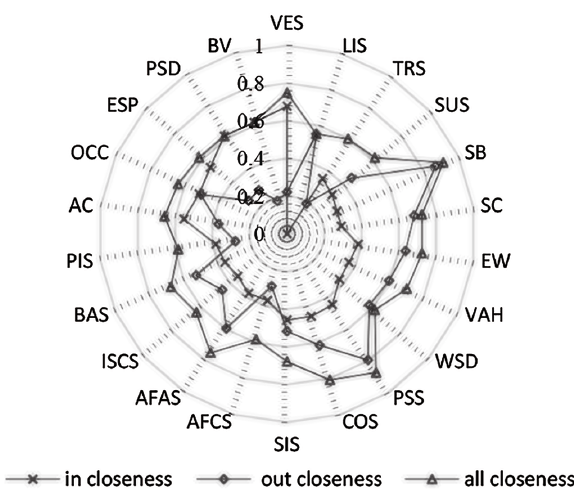
Figure 11. Values of in closeness, out closeness and all